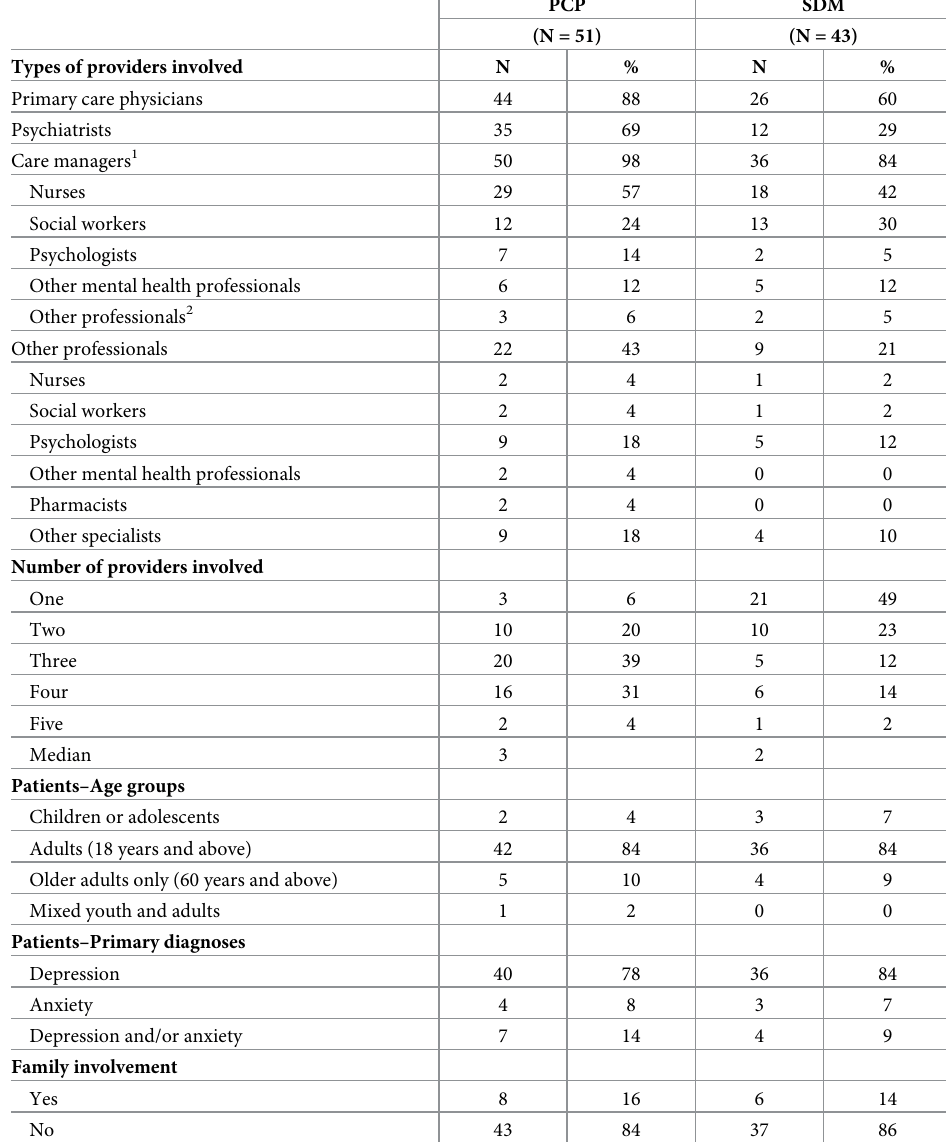
Table 2. Participants in personalized care planning (PCP) and shared decision making